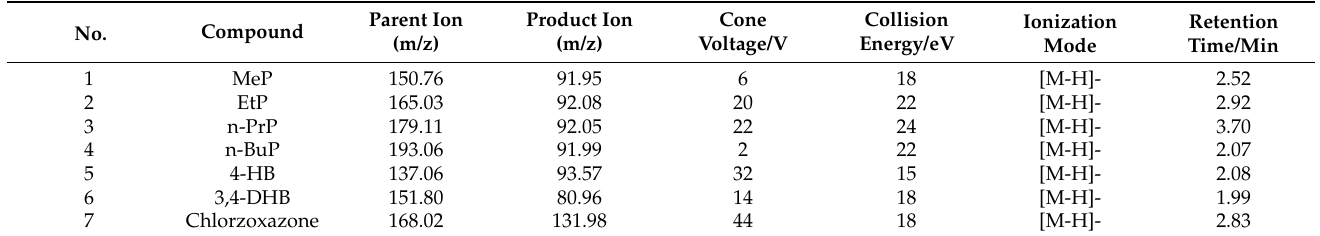
Table 1. MS conditions and retention times for each detected